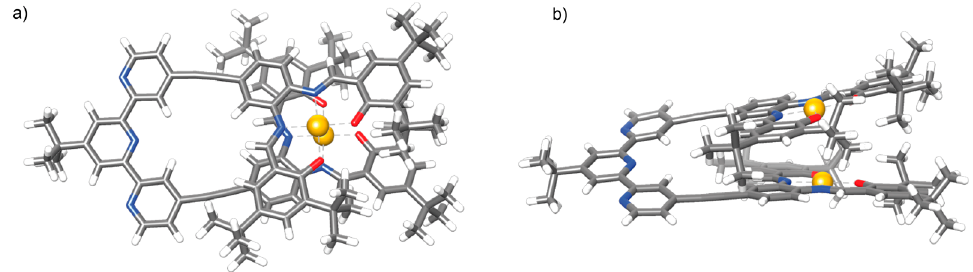
Figure 3. DFT-optimized structure of 1 (B3LYP/6-31G**/LanL2DZ); ( a ) top view and ( b ) side view.